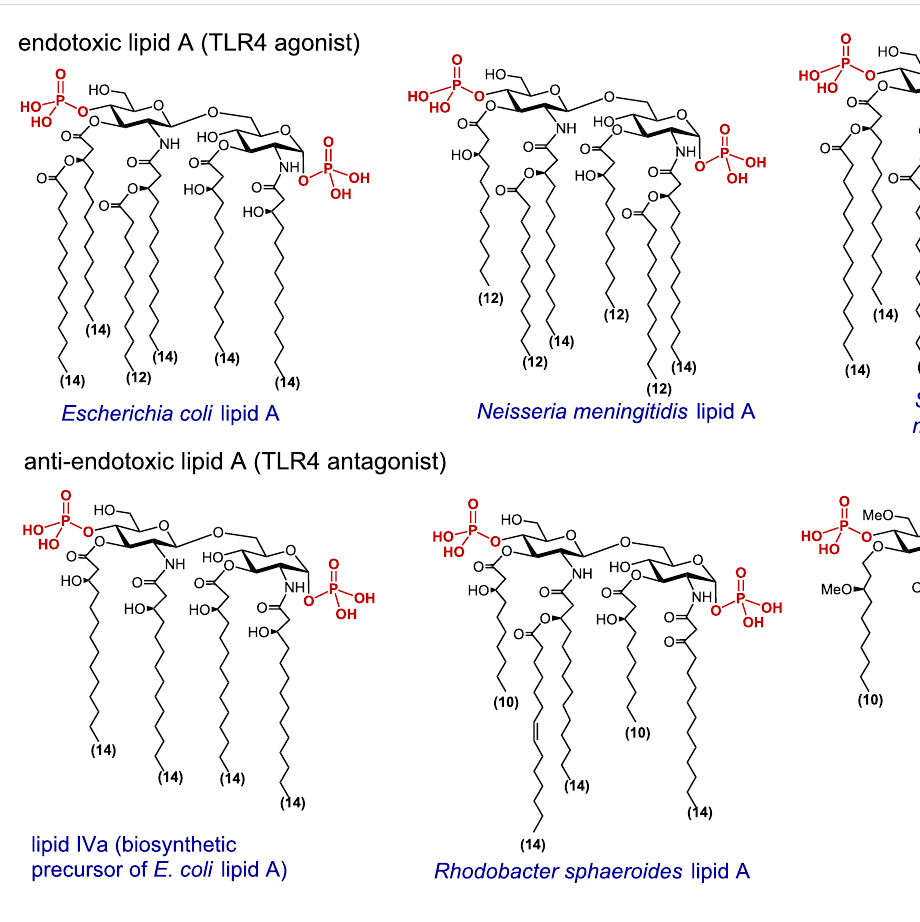
crucial factor in the pathogenesis of chronic inflammatory, autoimmune and infectious diseases [51-53]. A number of studies also suggested a possible implication of TLR4 in cardio- vascular disorders [54] and Alzheimer desease – associated